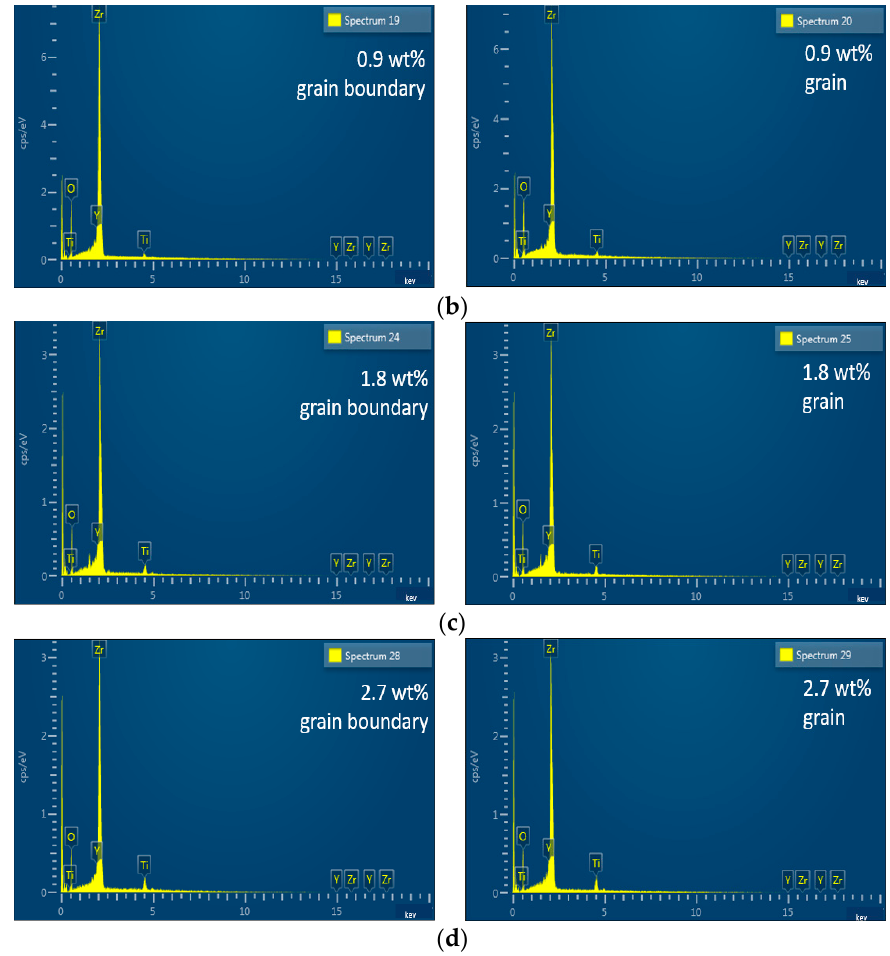
Figure 4. EDS analysis of the microwave-sintered 3Y-TZP ceramics as function of ( a ) 0, ( b ) 0.9, ( c ) 1.8, and ( d ) 2.7 wt% nano TiO 2 powders, sintered at 1250 °C.